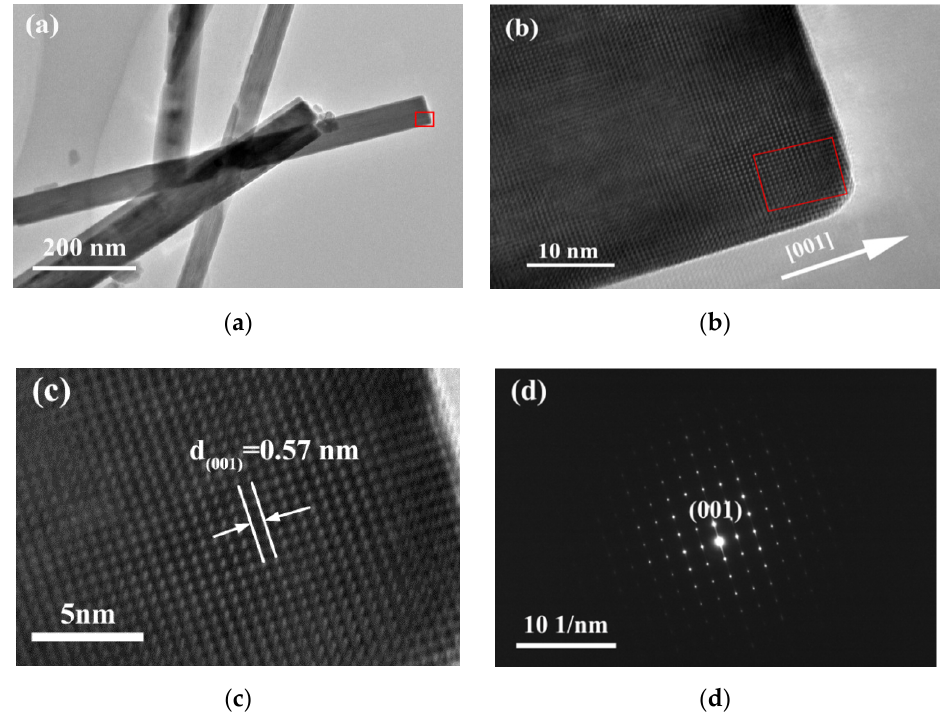
Figure 8. TEM, high-resolution transmission electron microscopy (HRTEM), and selected area electron diffraction (SAED) images of YMn 2 O 5 : ( a ) TEM; ( b ) HRTEM; ( c ) amplification of the HRTEM; ( d ) SAED.